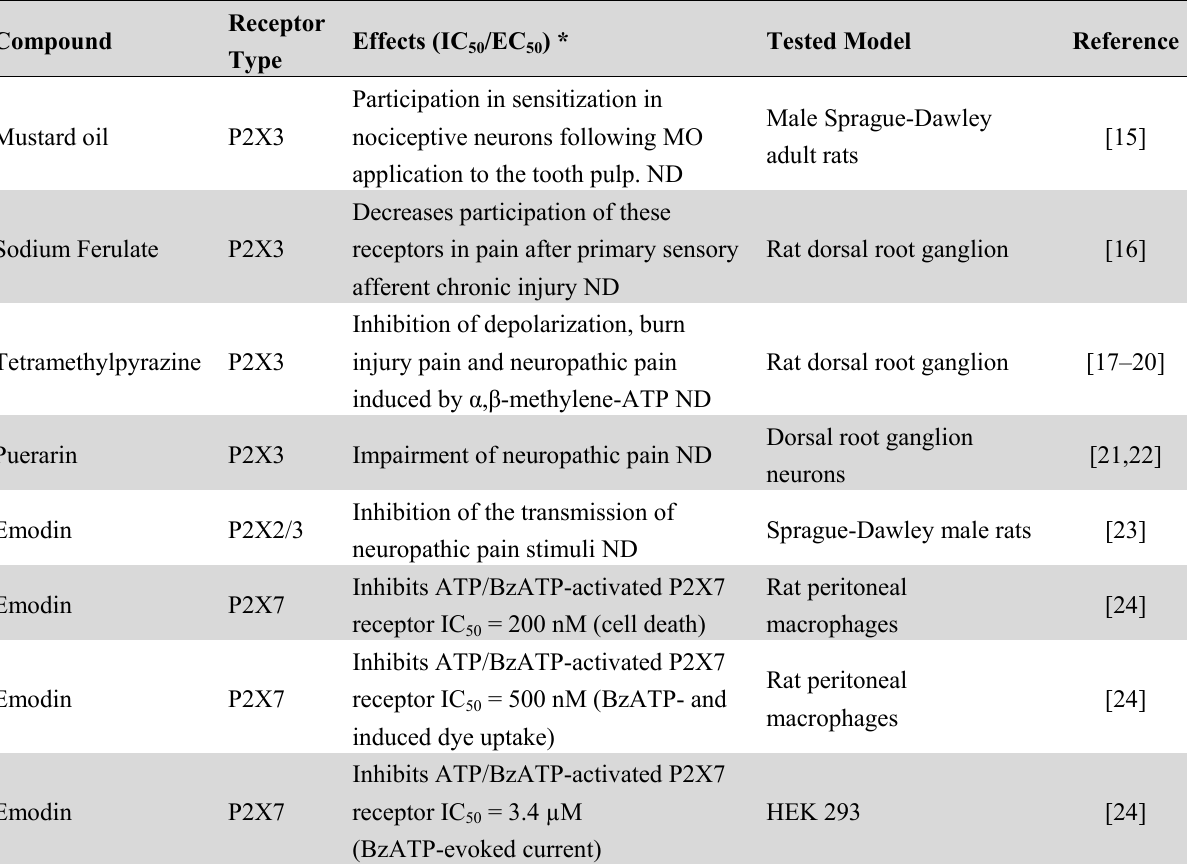
Table 1. Natural products from plant